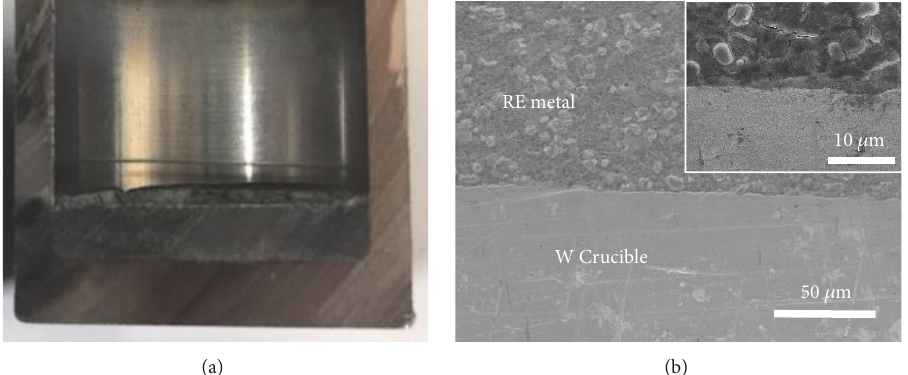
Figure 2: Images of molten RE metals in W crucible. (a) Macroscopic and (b) microscopic morphology of the resolidified product cross- section.